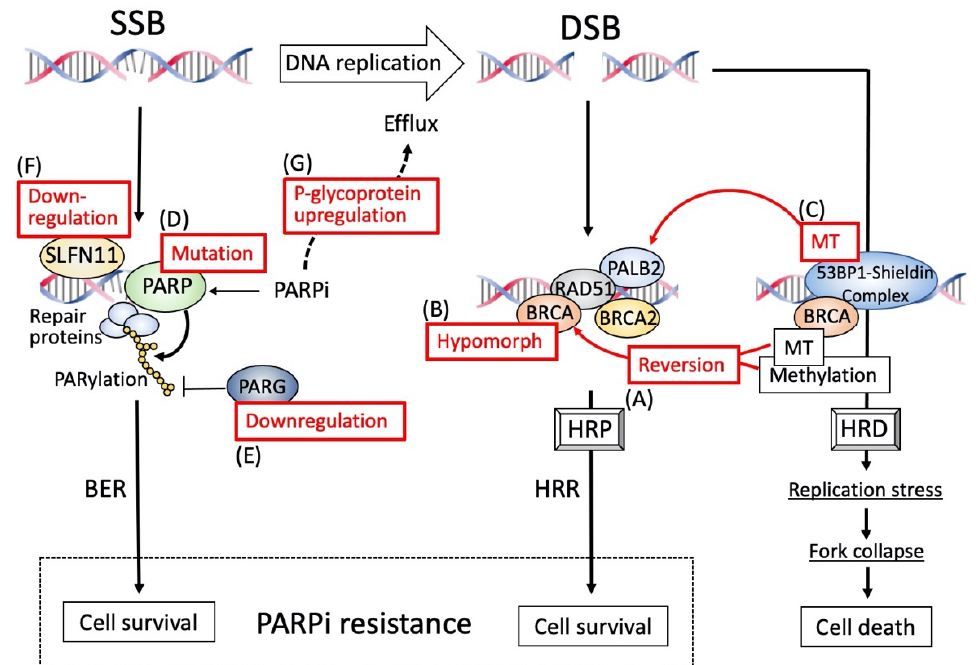
Figure 6. Various factors that involve PARPi resistance. PARPi resistance is conferred by proper repair of single strand breaks (SSBs) via PARP-dependent base excision repair (BER) or double strand breaks (DSBs) via homologous recombination repair (HRR), whereas DSBs cannot be repaired in the presence of the 53BP-Shieldin complex, which sequesters the PALB2-BRCA2-RAD51 complex, alternative repair molecules for HRR, conferring the HRD phenotype, leading to replication stress-induced fork collapse and cell death. Of various factors involved in PARPi resistance, seven representative causes are shown by numbers in red boxes that function to support the BER or HRR pathway. The acronyms are defined as follows: HRD, homologous recombination deficiency; HRP, homologous recombination proficiency; PALB2, partner and localizer of BRCA2; PARG, poly (ADP-ribose) glycohydrolase; RAD51, RAD51 recombinase; SLFN11, Schlafen family member 11; 53BP1, p53-binding protein 1.